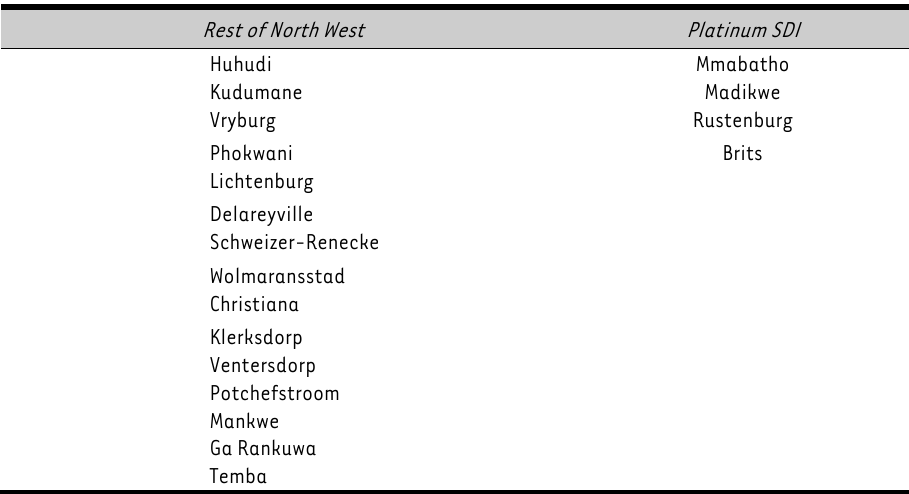
TABLE 1: Magisterial districts of the Platinum SDI and the rest of North West Province (1996 boundaries) Rest of North